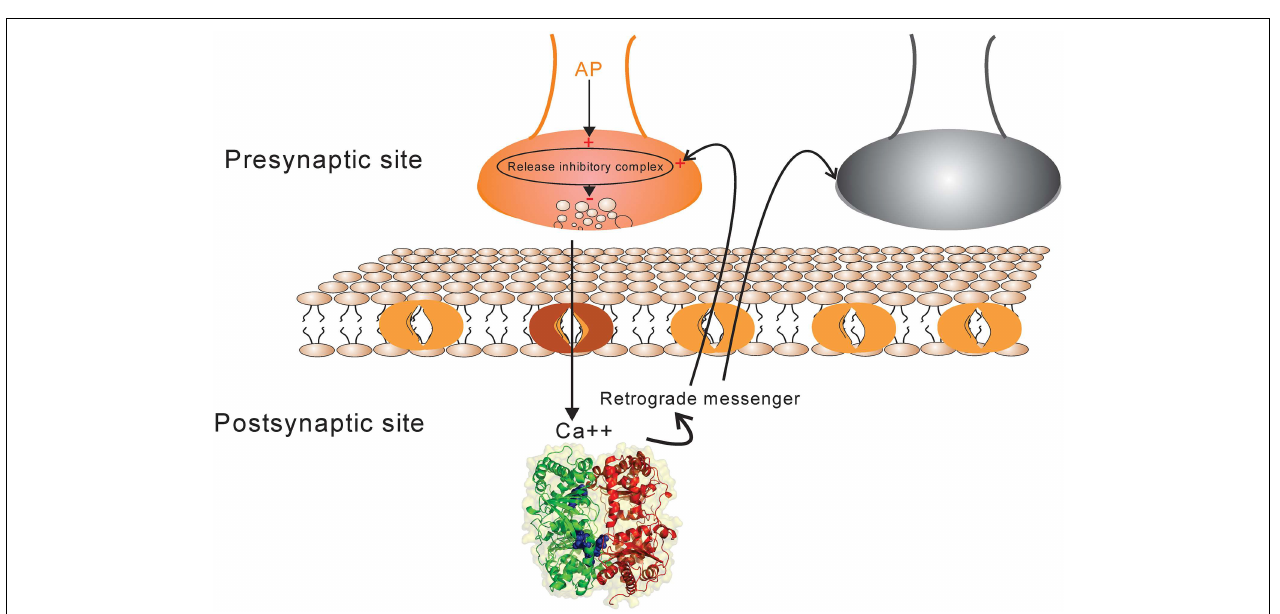
FIGURE 1 | The schematic of synapse model. Action potential in each activated synapse (presynaptic site shown by orange) may lead to neurotransmitter release according to the initial probability of release. Modified release probability induced by the activity of release inhibitory complex can change the pattern of neurotransmitter release which induces current into the postsynaptic site. The current influx is also affected by synaptic efficacy which is determined directly by presynaptic spike trace and indirectly by Hebbian mechanism. The retrograde